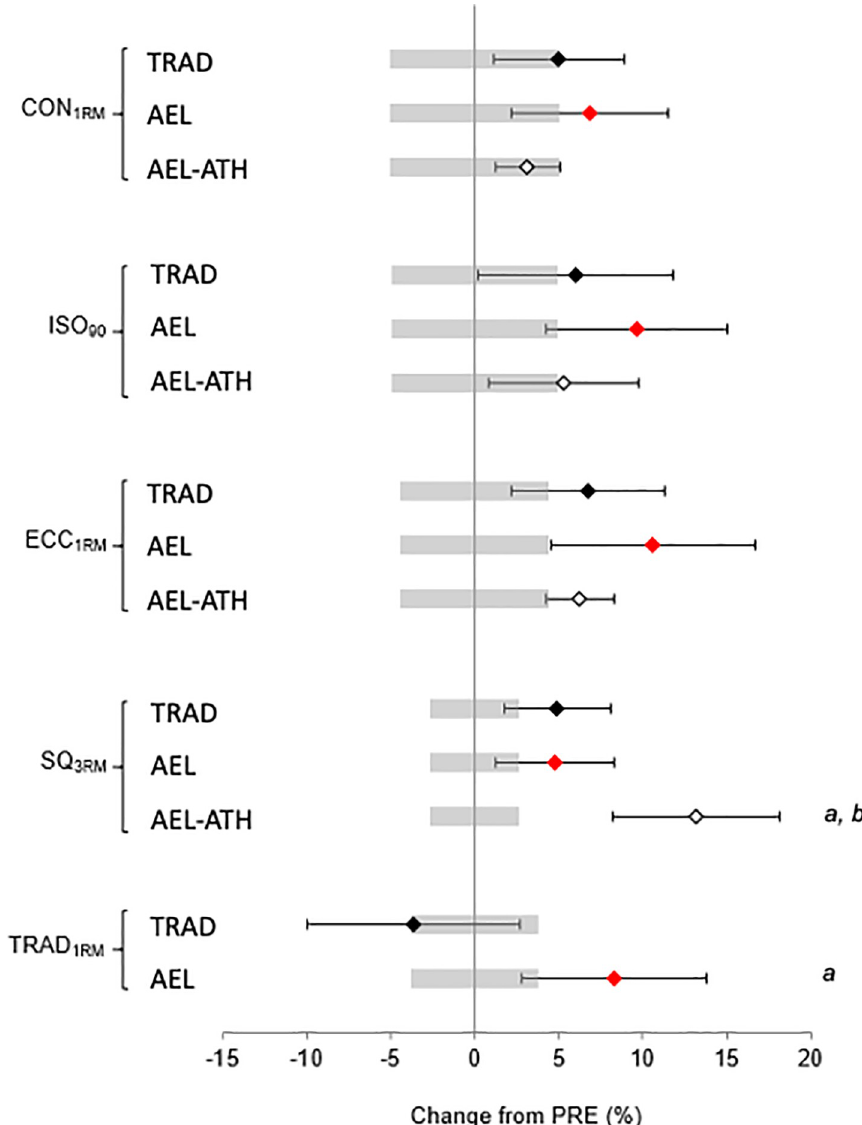
Fig 1. Relative changes ( ± 95% confidence intervals) in strength following training with (AEL, AEL-ATH) and without (TRAD) augmented eccentric loading. Shaded bars represent the measurement error for each outcome measure. a , different from TRAD, b , different from AEL ( p < 0.05).